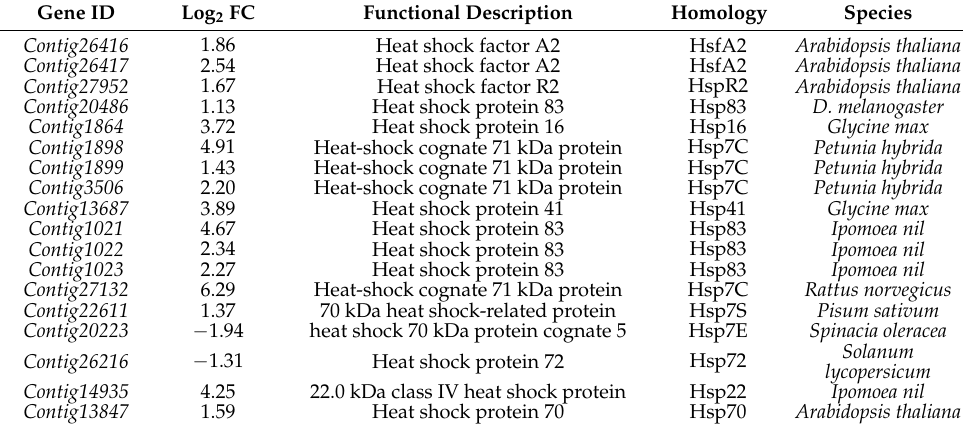
Table 4. Heat-shock proteins and heat transcription factors regulated by heat stress in red pitaya. Gene ID Log 2